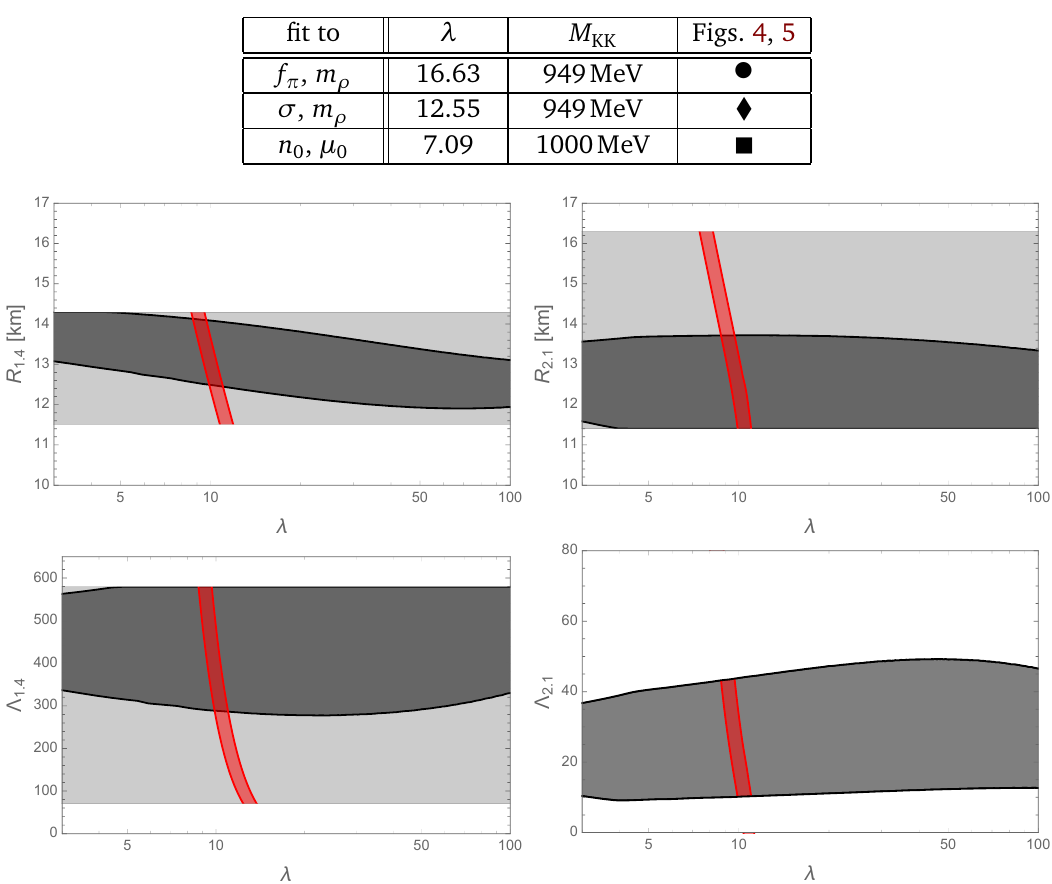
Table 1: Fits of the model parameters to vacuum properties (pion decay constant and rho meson mass [ 3,4 ] , first row, QCD string tension and rho meson mass [ 31 ] , second = 0.153fm − 3 and row), and to nuclear saturation properties (saturation density n 0 = 922.7MeV of symmetric nuclear matter, third row, this onset chemical potential µ 0 work).